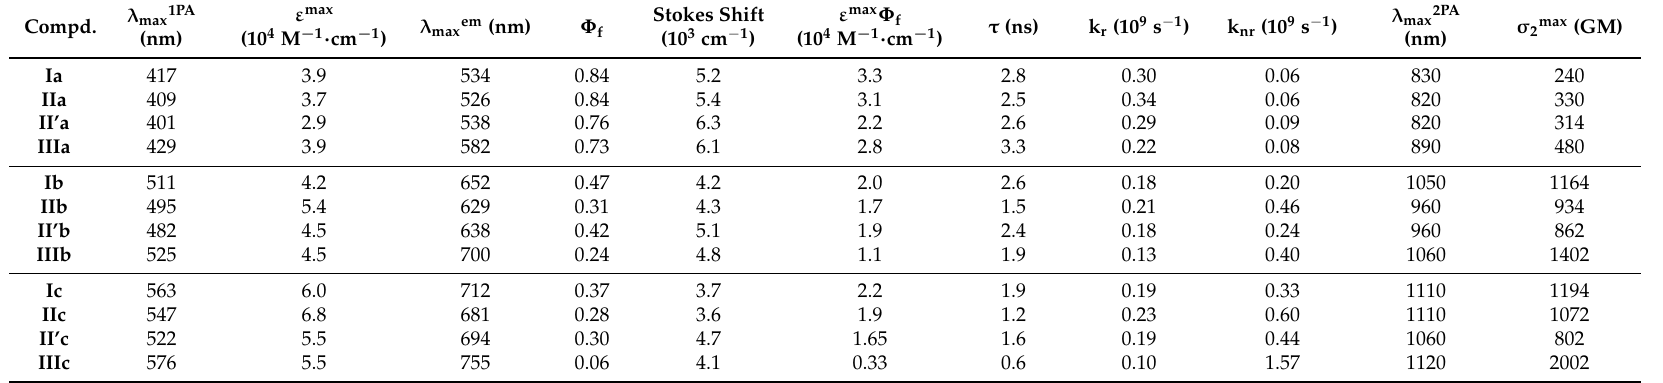
Table 2. One-photon and two-photon photophysical data of derivatives I – IIIa – c in CHCl 3